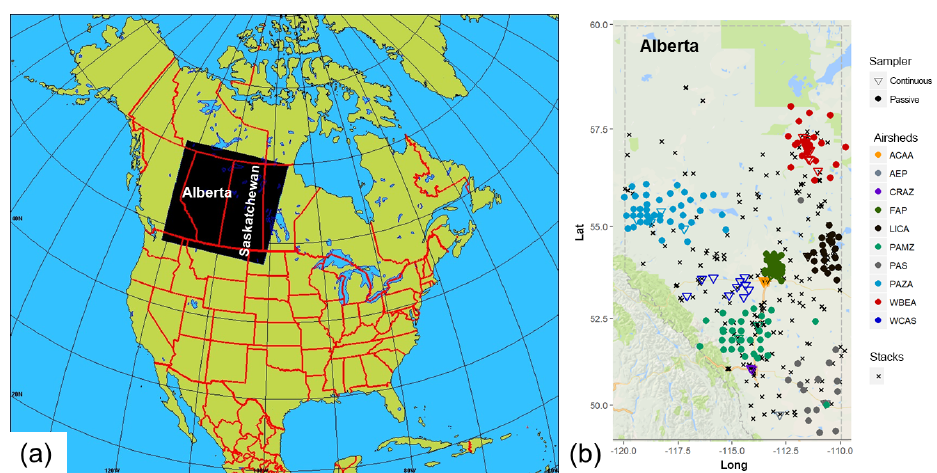
Figure 1. Study area: (a) model domain covering the provinces of Alberta and Saskatchewan; (b) NO 2 and SO 2 continuous and passive monitors located at the different air quality monitoring networks (airsheds) and main NO 2 and SO 2 stacks in the province of Alberta. Stations are colour-coded according to airsheds and plotted with different polygons (circle for passive, inverted triangle for continuous): West Central Airshed Society (WCAS), Wood Buffalo Environmental Association (WBEA), Fort Air Partnership (FAP), Alberta Capital Airshed Alliance (ACAA), Calgary Regional Airshed Zone (CRAZ), Peace Airshed Zone Association (PAZA), Palliser Airshed Society (PAS), Parkland Airshed Management Zone (PAMZ), and Lakeland Industrial Community Association